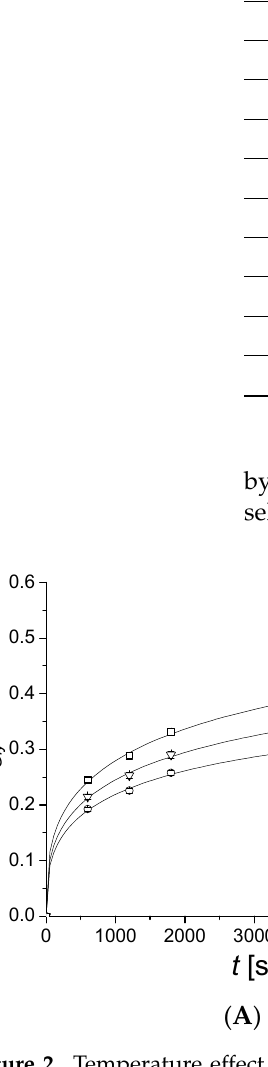
Figure 2. Temperature effect for catalyzed tests, fixing v = 400 rpm, Ac/Gly = 4:1 mol/mol, and ρ CAT = 0.02 kg/m 3 . ( A ) Glycerol conversion. ( B ) Selectivity toward solketal.